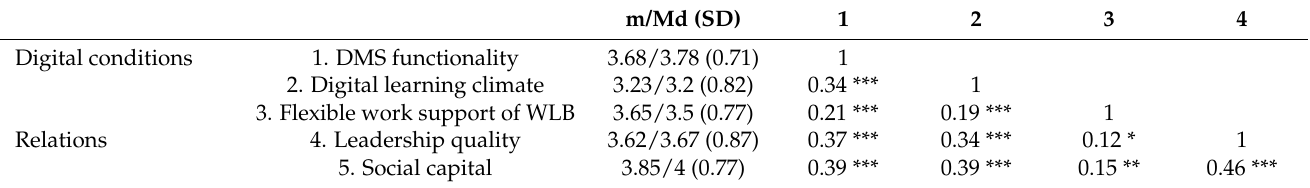
Table 2. Bivariate